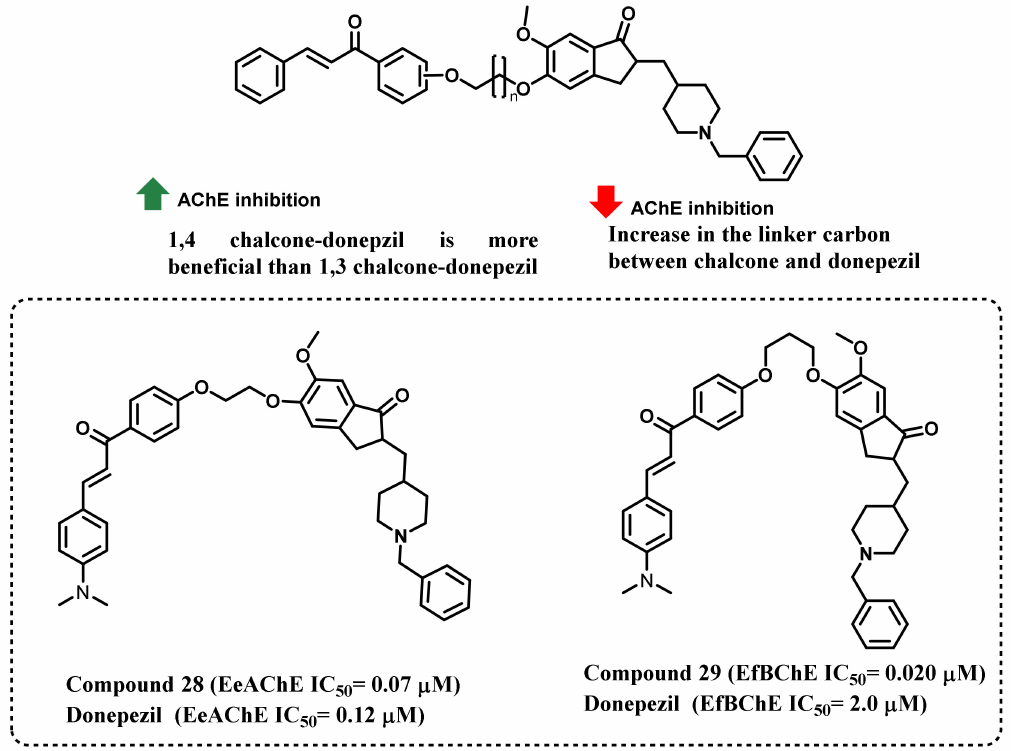
Figure 26. Chemical structures of donepezil–chalcone hybrid derivatives.